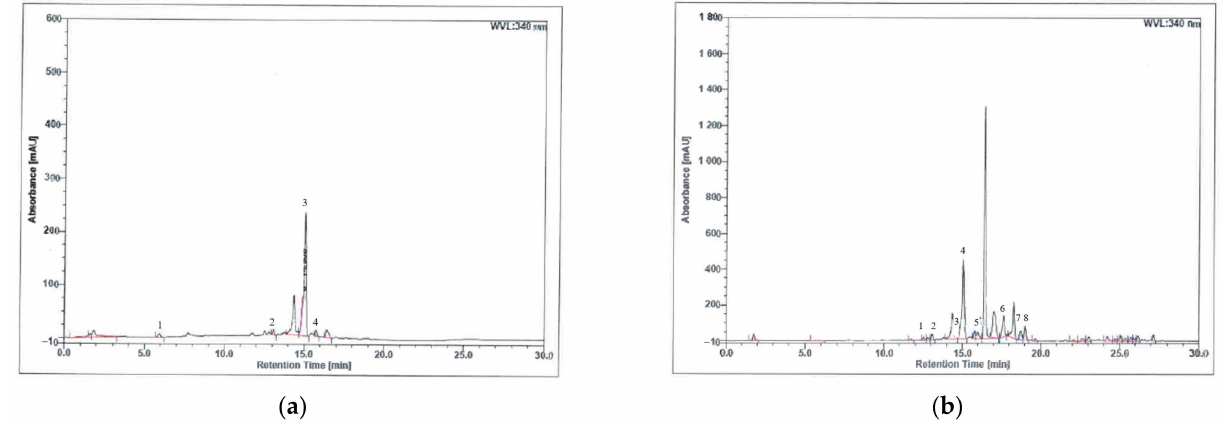
Figure 1. HPLC profiles of ( a ) aqueous and ( b ) methanol extracts of bee bread samples at 340 nm. ( a ) Peak 1, gallic acid; peak 2, mangiferin; peak 3, trans 3-hydroxycinnamic acid; peak 4, 2-hydroxycinnamic acid. ( b ) Peak 1, caffeic acid; peak 2, mangiferin; peak 3, trans ferulic acid; peak 4, trans 3-hydroxycinnamic acid; peak 5, 2-hydroxycinnamic acid; peak 6, quercetin; peak 7, kaempferol; peak 8, apigenin.